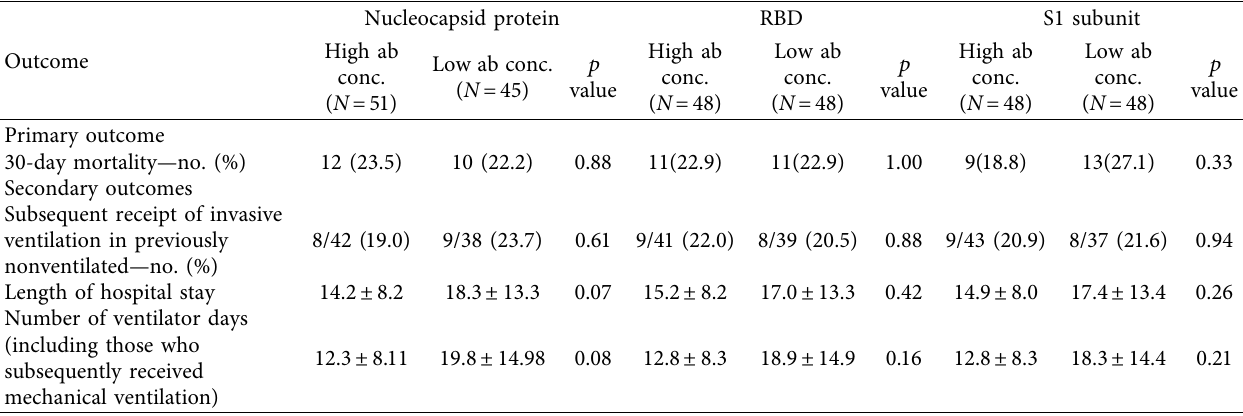
Table 2: Primary and secondary